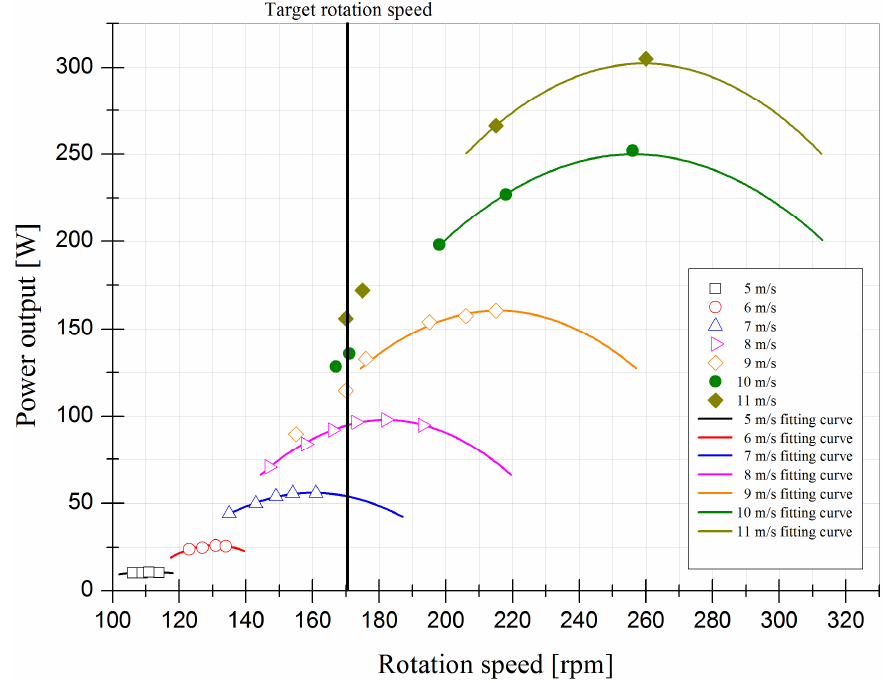
Figure 9. Graph of power output according to wind velocity obtained from wind tunnel test (symbols: test results; lines: fitting curve).